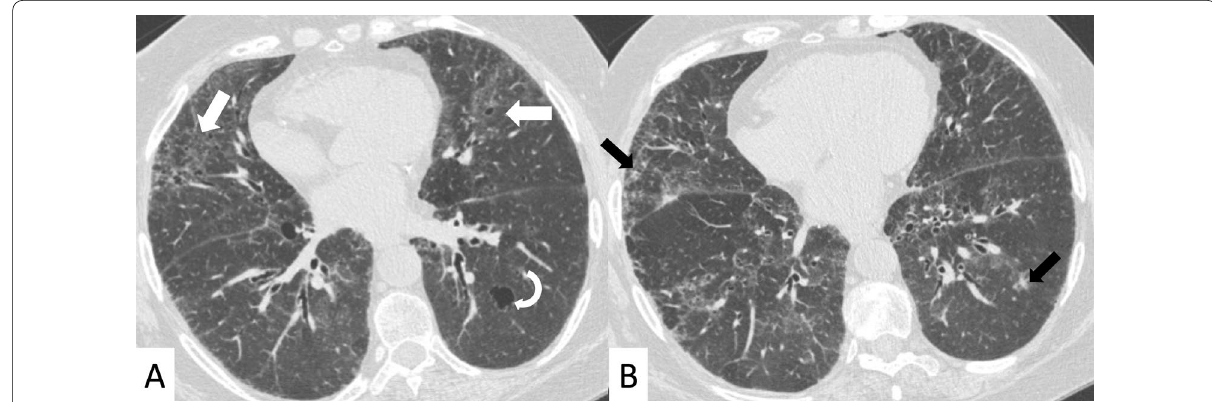
Fig. 23 LIP pattern in a 77-year-old female patient. A , B Ground-glass opacifications superimposed on a reticular pattern (white arrows in A )—reflecting the lymphocytic infiltration; there are also thin-walled peribronchovascular cysts (white curved arrow in A ) and centrilobular and subpleural nodules (black arrows in B )